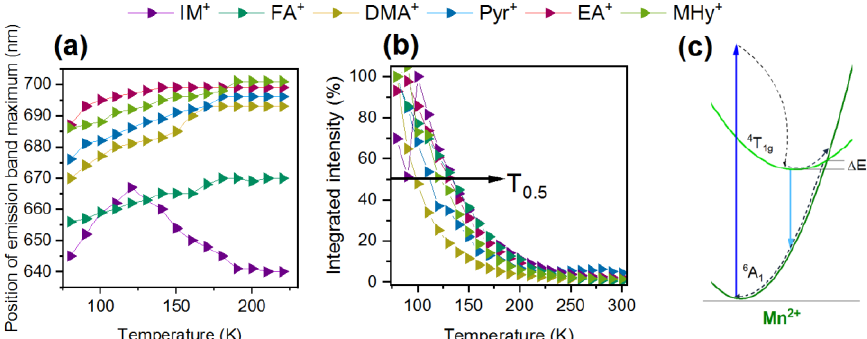
Figure 6. ( a – f ) Temperature-dependent emission spectra of the investigated manganese hypophos- phite perovskites.